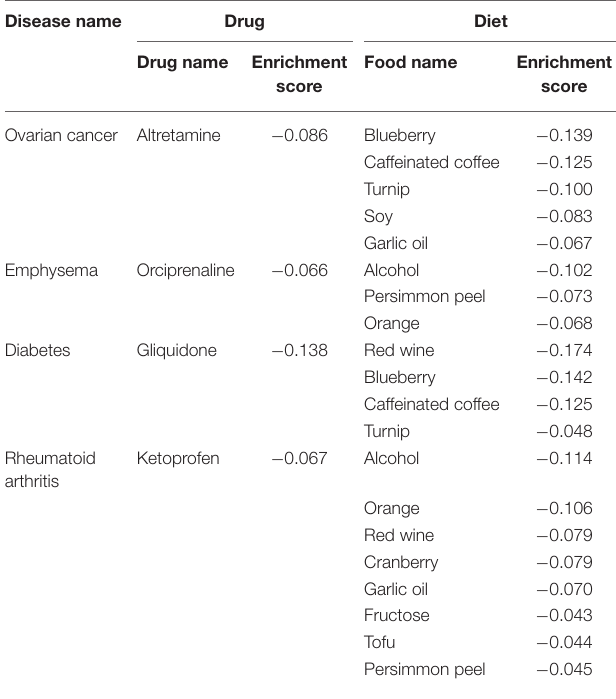
TABLE 1 | Enrichment score comparisons between anti-correlated diet and recovered known drugs against diseases.